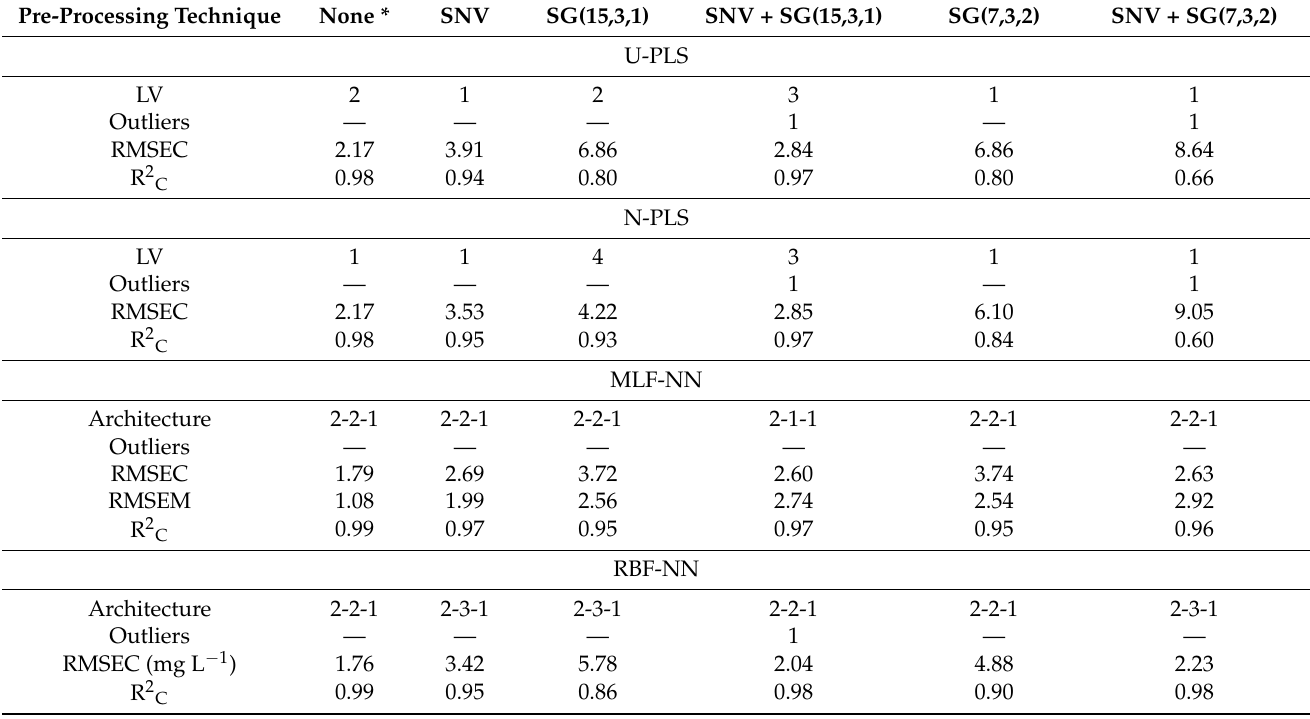
Table 3. Obtained results for the optimization of unfolded-partial least squares (U-PLS), N-way partial least squares (N-PLS), multilayer feed-forward neural networks (MLF-NNs) and radial basis function neural networks (RBF-NNs)